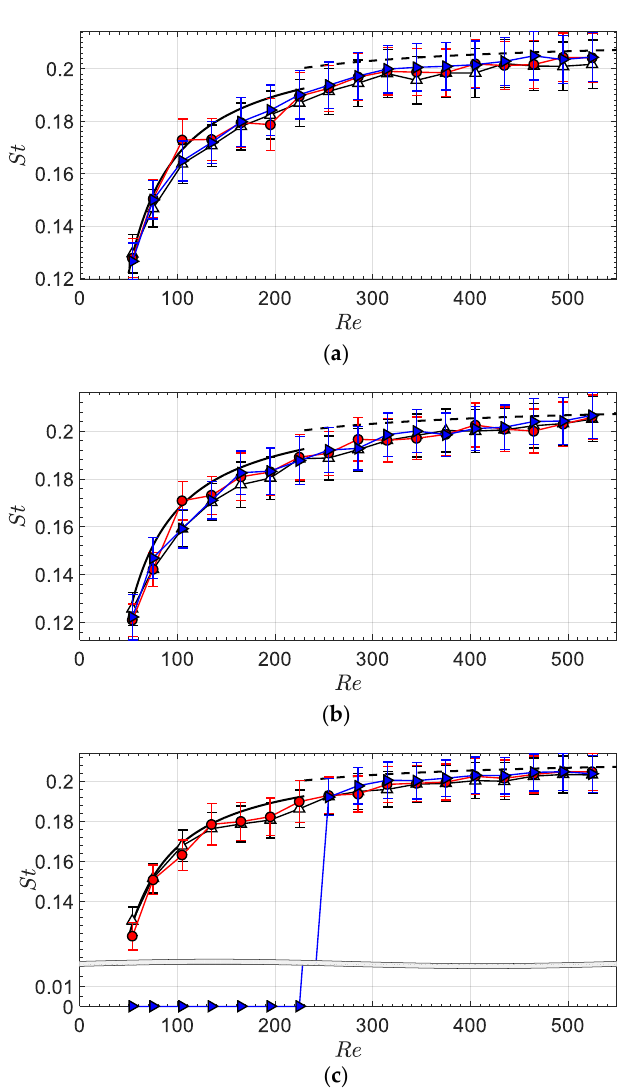
Figure 5. Experimental setup validation: Strouhal number versus Reynolds number for the smooth Figure 9. Strouhal number versus Reynolds number along the bent cylinder inclined leg at different circular cylinder in cross-flow: fixed-fixed cylinder ( a ), and bent cylinder in its asymptotic limiting inclinations: 45° ( a ); 30° ( b ); 15° ( c ). Symbols : 𝑠/𝐿 𝑖 = 0 (△),0.5(○),1(⊳) . Continuous line: Equation (3); configuration at 90° yaw angle ( b ). Symbols: 𝑠/𝐿 (cid:3036) (cid:3404) 0 (cid:4666)△(cid:4667), 0.5(cid:4666) ○ (cid:4667) . Continuous line: inclinations: 45 ◦ ( a ); 30 ◦ ( b ); 15 ◦ ( c ). Symbols: s / L i = 0 ( (cid:52) ) ,0.5 ( Dashed line: Equation (4). Equation (3); Dashed line: Equation (4). (3); Dashed line: Equation